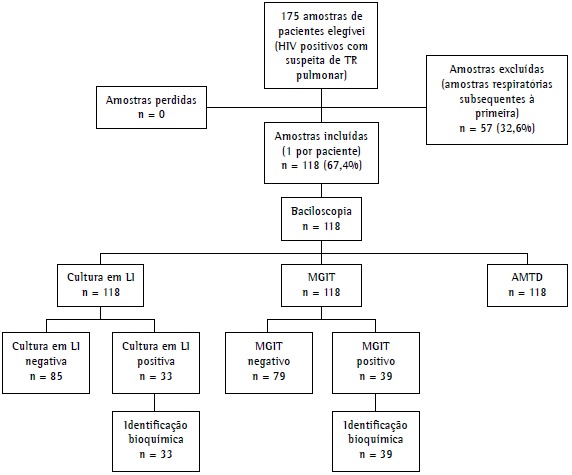
Diagrama do estudo. TB: tuberculose; LJ: Löwenstein-Jensen; MGIT:
Mycobacteria Growth Indicator Tube; e AMTD: teste amplified Mycobacterium
tuberculosis direct.